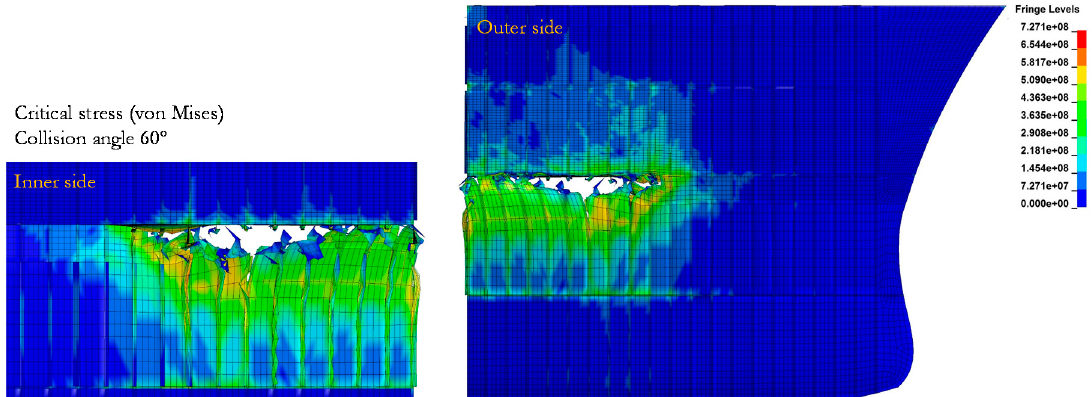
Figure 13. Critical stress (von Mises formulation) of the collision Angle 60°.